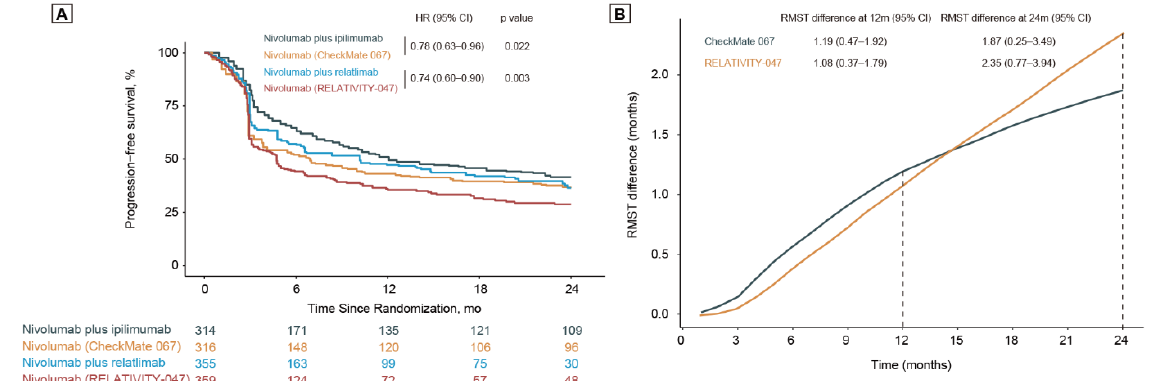
Figure 2. Survival analysis of the CheckMate-067 and RELATIVITY-047 trials. ( A ) Kaplan–Meier curves and log-rank test of CheckMate-067 and RELATIVITY-047 trials. The events that occurred after 24 months were censored to improve the comparability of these two trials. ( B ) The difference in RMST between experimental groups and control groups of CheckMate-067 and